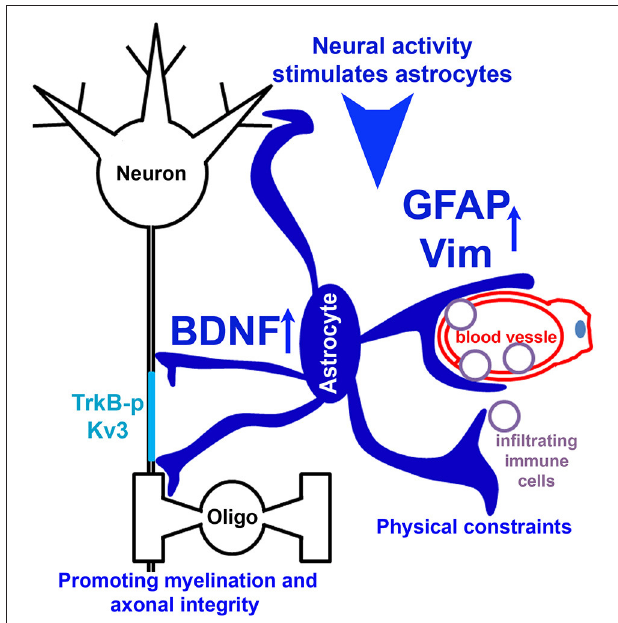
FIGURE 9 | Hypothetical model diagram of the role of Kv3 channels in lesion formation in EAE and MS. Neural activity stimulates radial astrocytes, which upregulate the expression of GFAP and Vim, as well as BDNF. Upregulated intermediate filaments (GFAP and Vim) increase the rigidness of astrocytes, thereby deterring migration and proliferation of infiltrating immune cells to limit lesion formation. On the other hand, BDNF signaling promotes axon remyelination and prevents axonal degeneration, and thus contributes to lesion